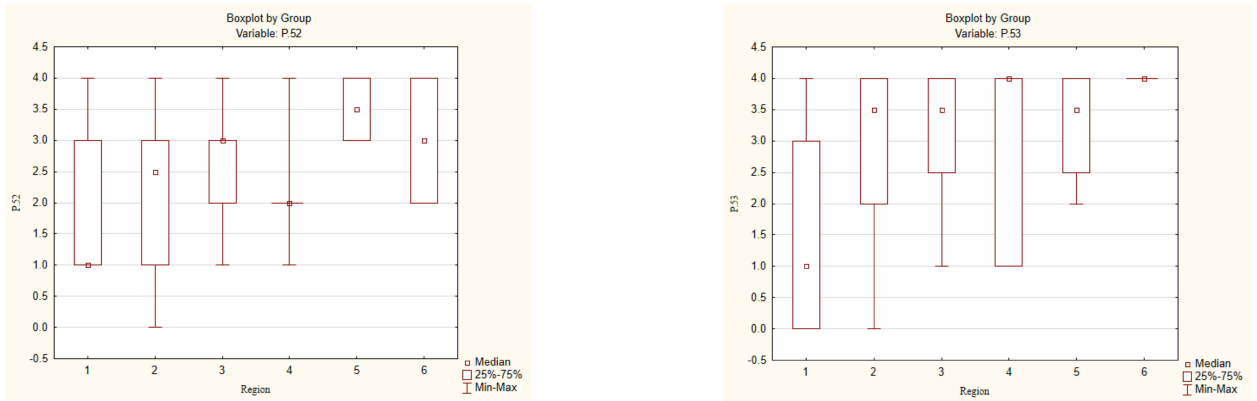
Figure 16. Box and whisker diagrams by practices P52 (Reducing idling of the car), P53 (Maintaining air pressure of the tire), category